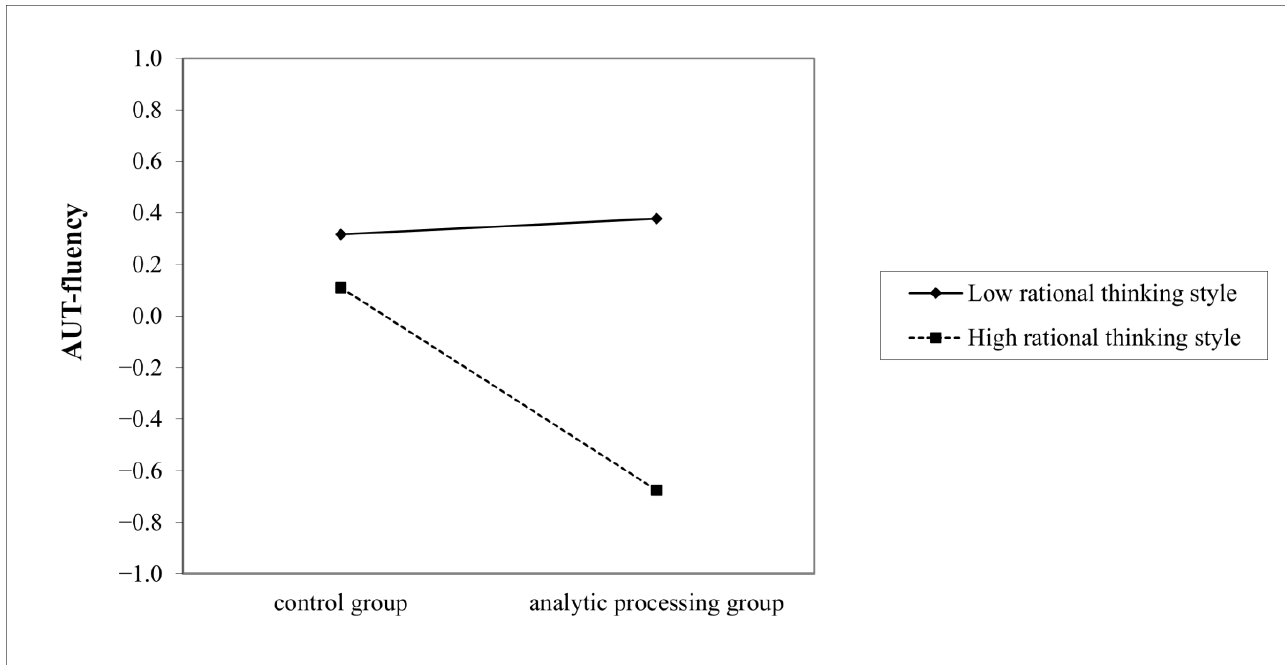
Figure 1. The interaction between rational thinking style and analytic processing prime on fluency.